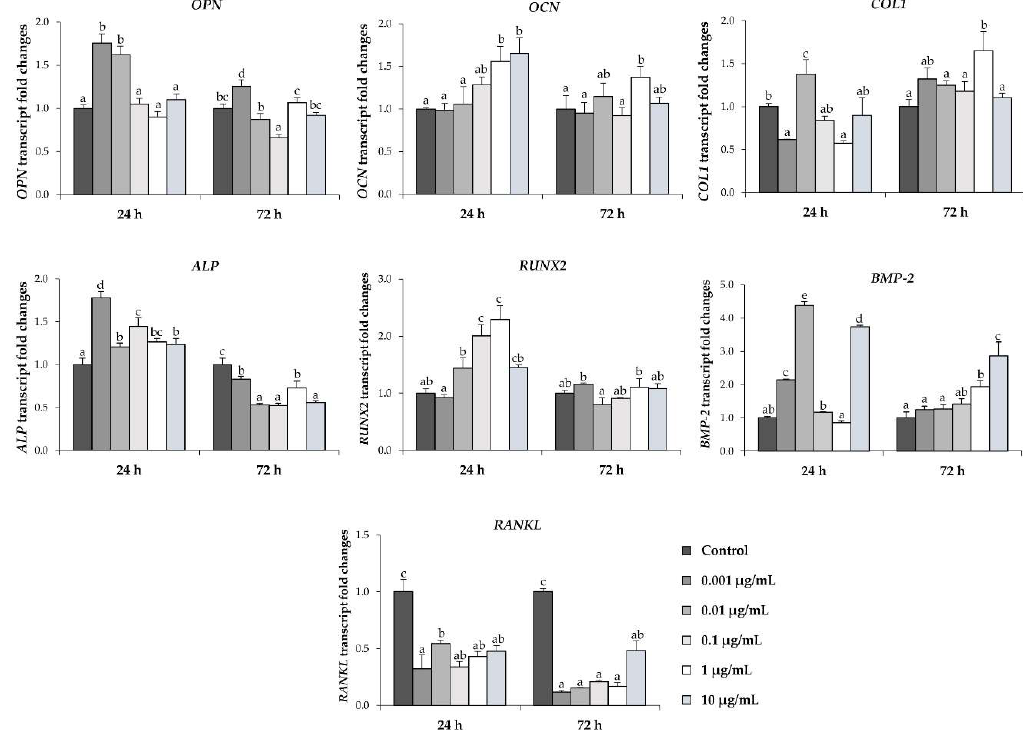
Figure 5. Quantitative real-time PCR was used to analyze the expression of OPN , OCN , COL1 , ALP , RUNX2 , BMP2 , and RANKL in osteoblast differentiation from MC3T3-E1 cells treated with the various concentrations of L -quebrachitol for 24 and 72 h. A representative example of 3 independent experiments. Each data point represents the means of 4 replicate samples ± SEM. The data in columns with different letters in each group were significantly different at p < 0.05.